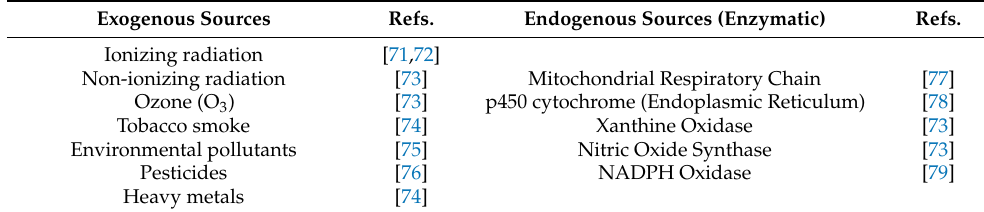
Table 1. Biological sources of ROS generation.